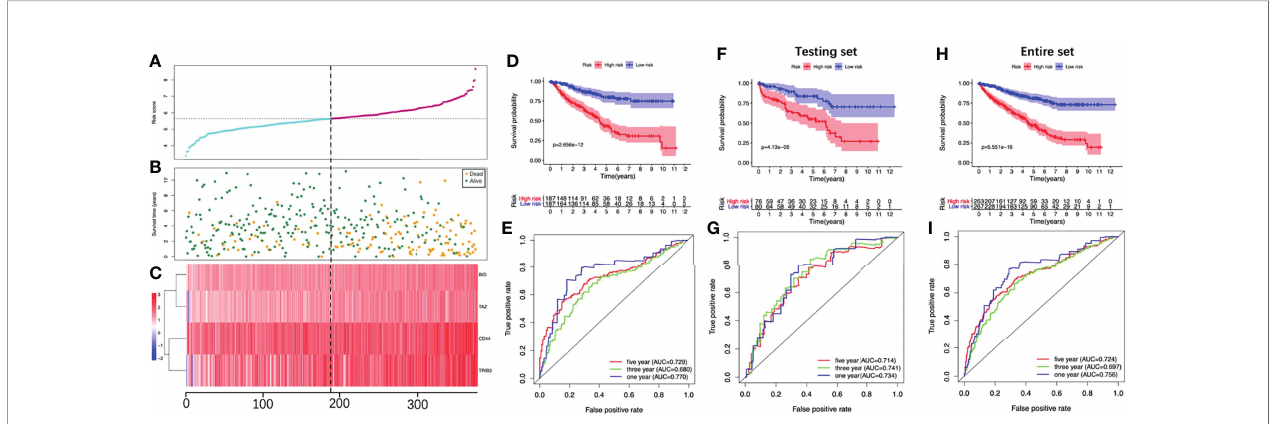
FIGURE 5 | Evaluate the prognostic analysis of the four-FRG model in the training set (A-E) and validate in the testing set (F, G) and the entire set (H, I) . (A) The curve of risk score. (B) Survival status of the ccRCC patients. (C) Heatmap of the expression levels of the four optimal PR-FRGs. The dotted line represented the median risk score and strati fi ed the ccRCC patients into low-risk and high-risk group. (D) K-M survival analysis of the model. (E) Time- dependent ROC analysis of the model. (F) K-M survival analysis in the testing set. (G) Time-dependent ROC analysis in the testing set. (H) K-M survival analysis in the entire set. (I) Time-dependent ROC analysis in the entire set. CcRCC, clear cell renal cell carcinoma; PR-FRGs, prognosis-related FRGs; K-M, Kaplan – Meier; ROC, receiver operating